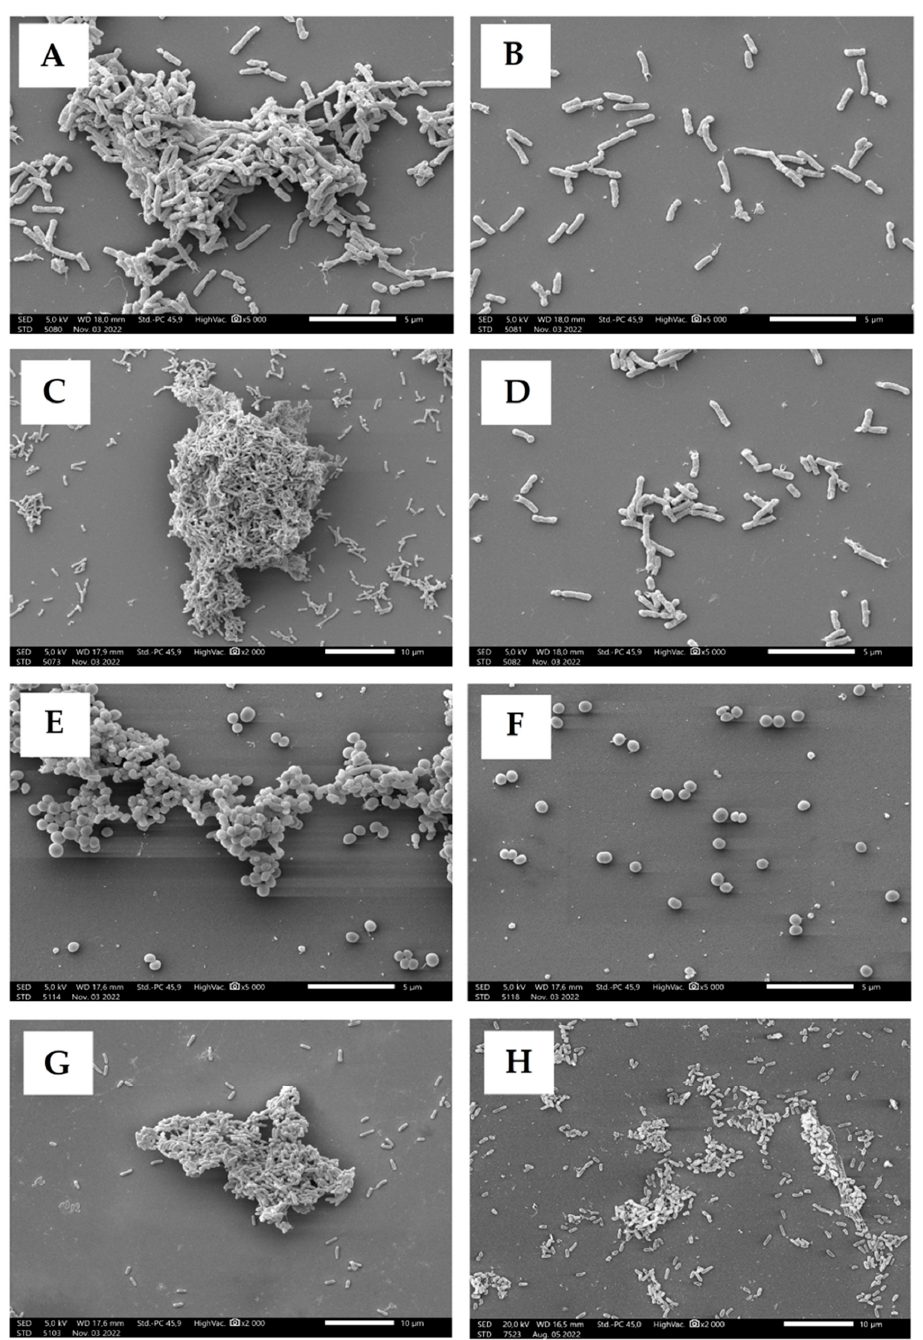
Figure 3. Scanning electron microscopy photographs of examined strains, control samples: ( A )— H. in fl uenzae , ( C )— H. parain fl uenzae , ( E )—MRSA, ( G )— P. aeruginosa . Samples treated with EO of O. majorana ( 5 ): ( B )— H. in fl uenzae , ( D )— H. parain fl uenzae , ( F )—MRSA, ( H )— P. aeruginosa